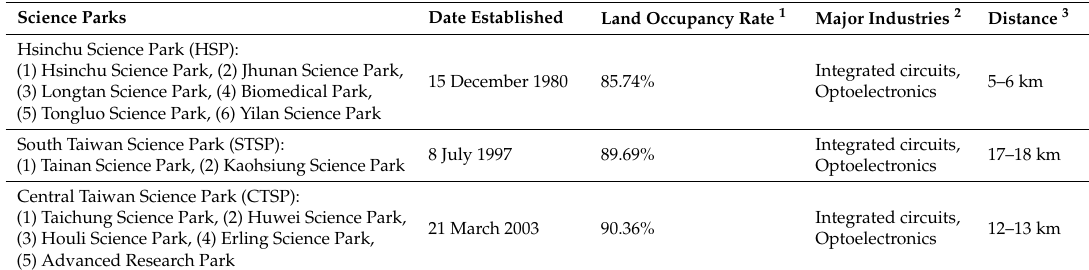
Table 1. Science parks in